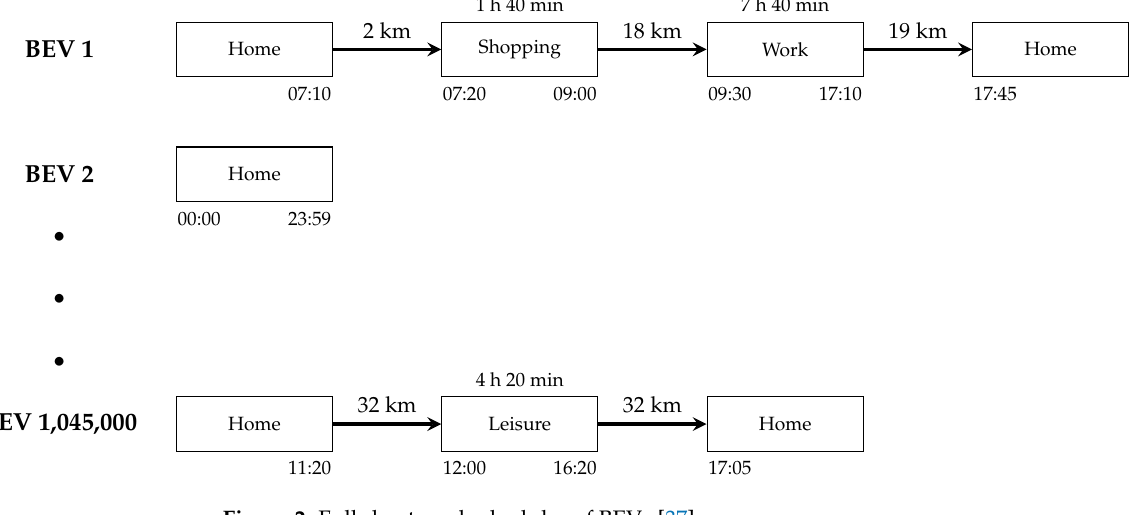
Figure 2. Full-day travel schedules of BEVs